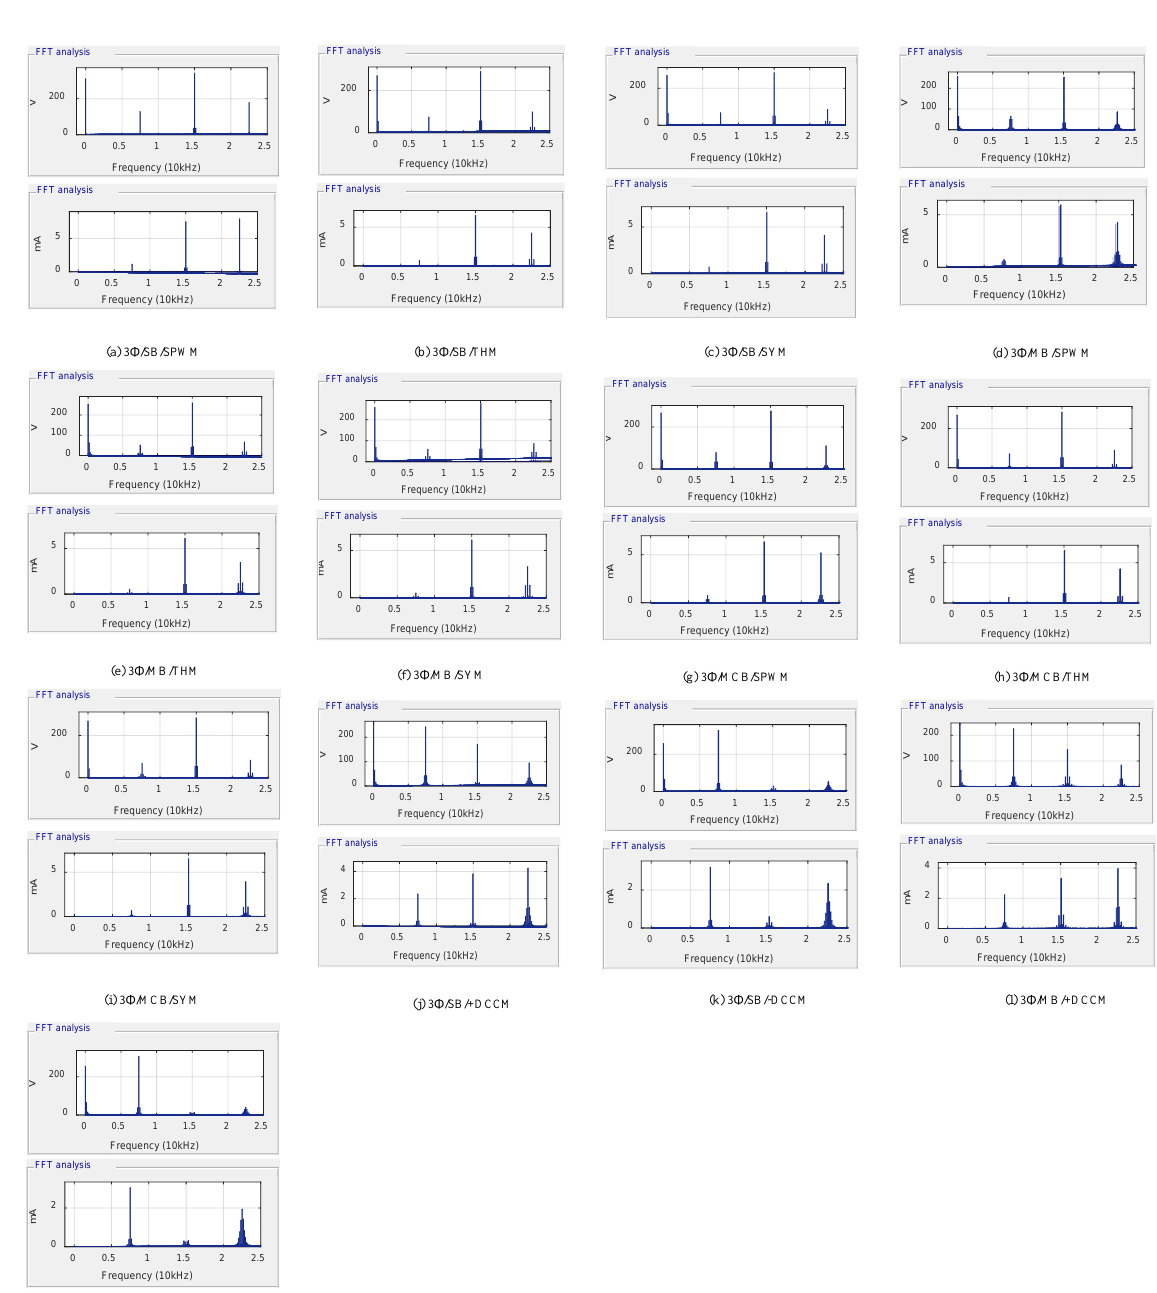
Figure 13. The 3ф ST FFT of CMV and leakage current at Vph = 220 V. Figure 13. The 3 ф ST FFT of CMV and leakage current at V